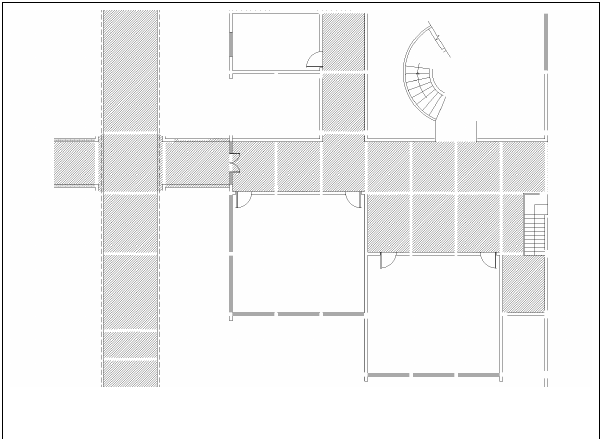
Figure 5: Floor-plan of a part of the ground floor of the Himalaya building